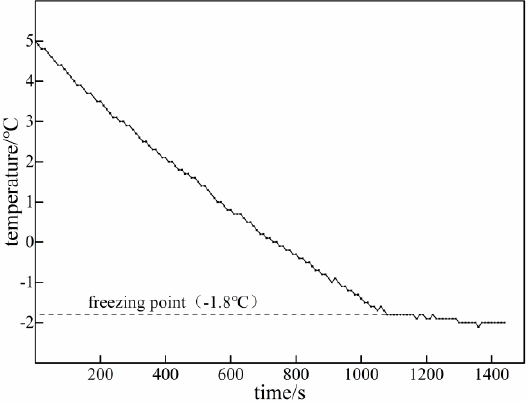
Figure 4. Variations in temperature during ice slurry production at different initial NaCl concentrations.